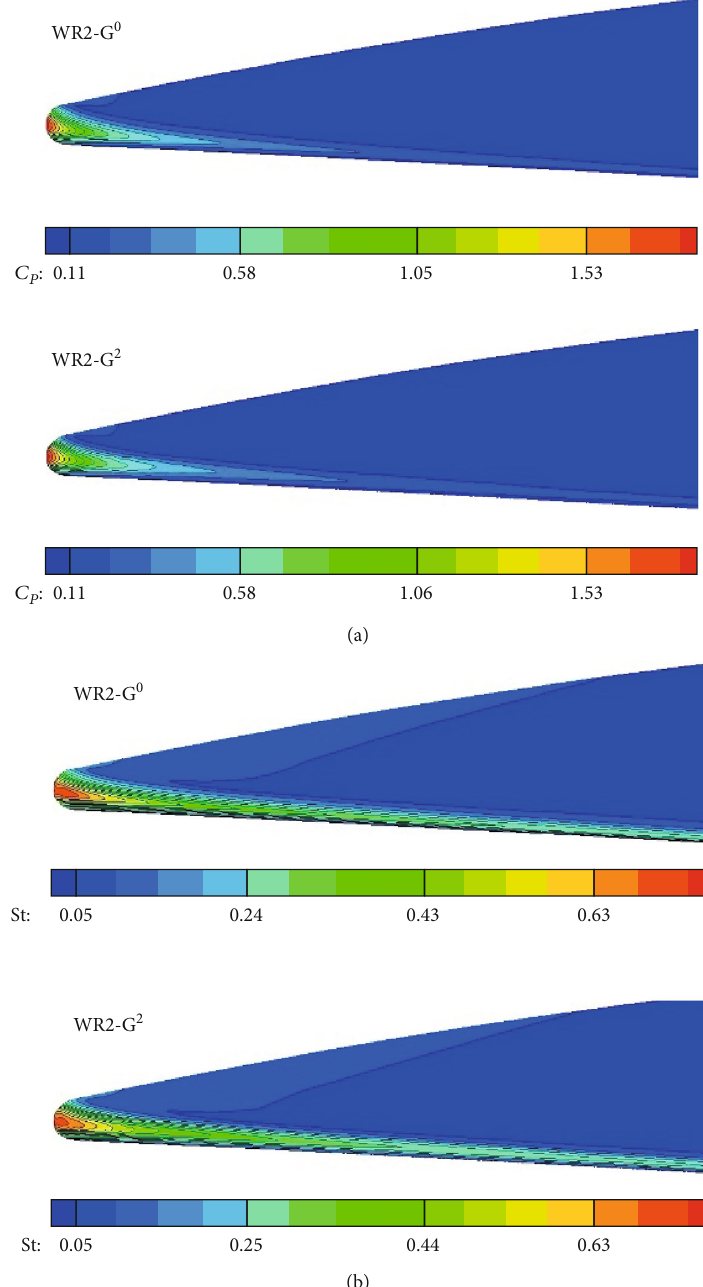
Figure 16: Contours of surface characteristics alongside leading edges of WR2-G 0 and WR2-G 2 : (a) contours of C